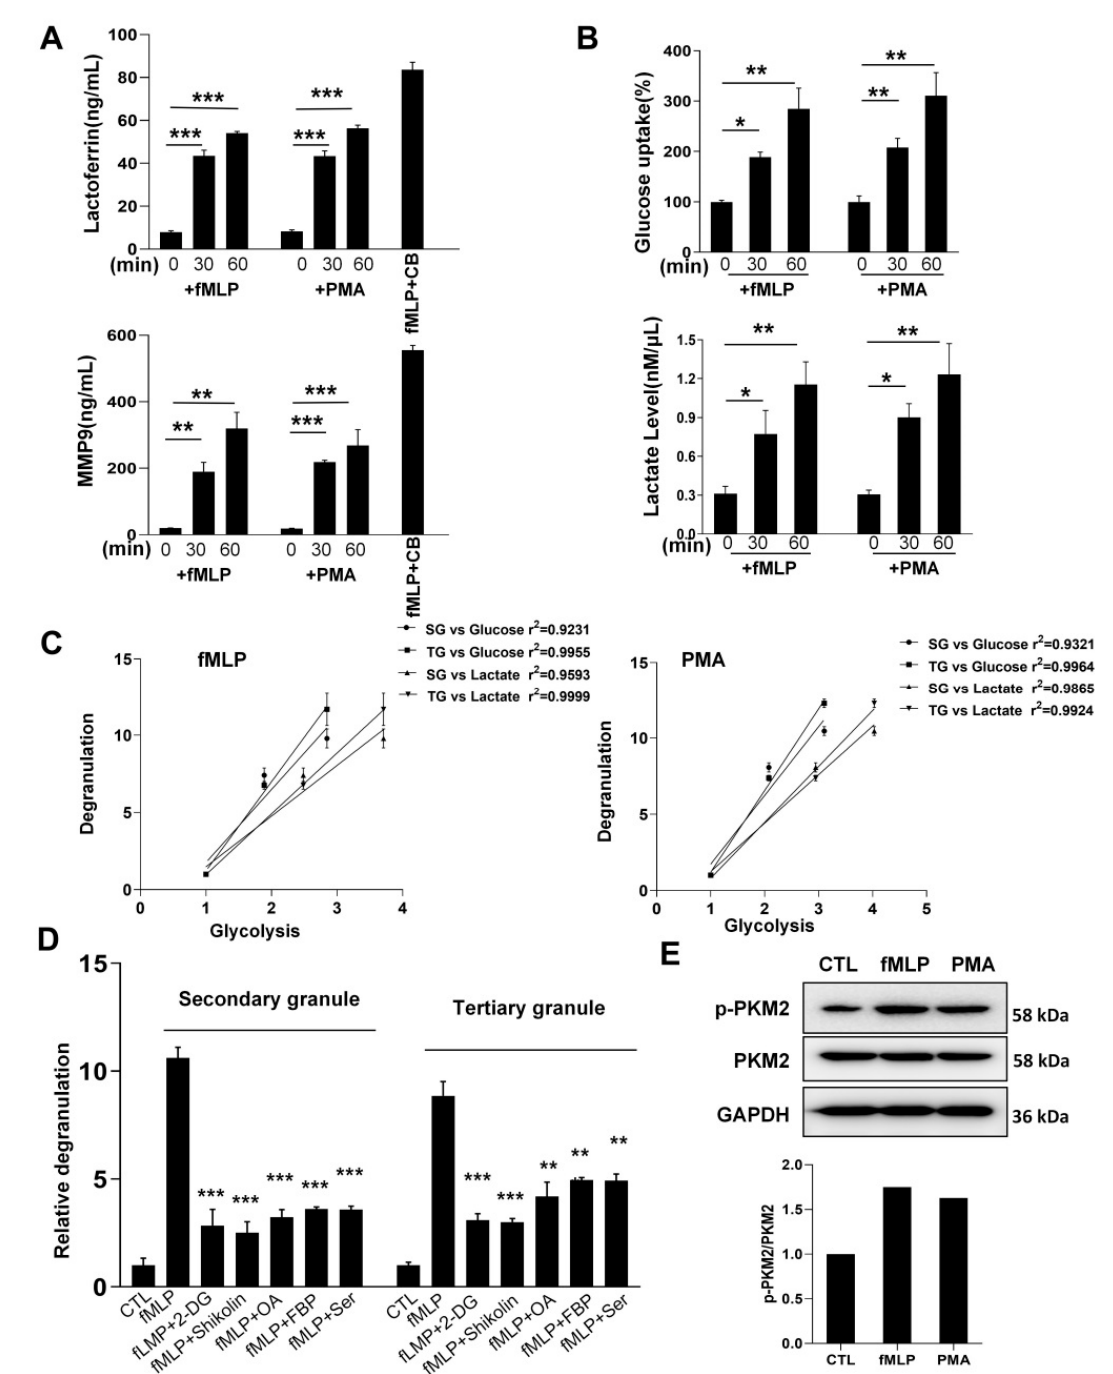
Figure 1. PMN aerobic glycolysis controls the degranulation of secondary and tertiary granules. Human PMNs were isolated from peripheral blood and treated with fMLP (10 − 6 M) and PMA (10 − 7 M) for various durations. ( A ) Degranulation of secondary and tertiary granules represented by the release of lactoferrin and MMP9, respectively. ( B ) Glucose uptake and lactate production during PMN degranulation. ( C ) Correlation between fMLP- and PMA-induced aerobic glycolysis and degranulation of secondary and tertiary granules. ( D ) Inhibition of fMLP- or PMA-induced degranulation of secondary and tertiary granules by aerobic glycolysis inhibitors. ( E ) Enhanced phosphorylation of PKM2 in human PMN by fMLP or PMA stimulation. Data are represented as mean ± SEM. NS, No significance. *, p < 0.05. **, p < 0.01. ***, p < 0.001.